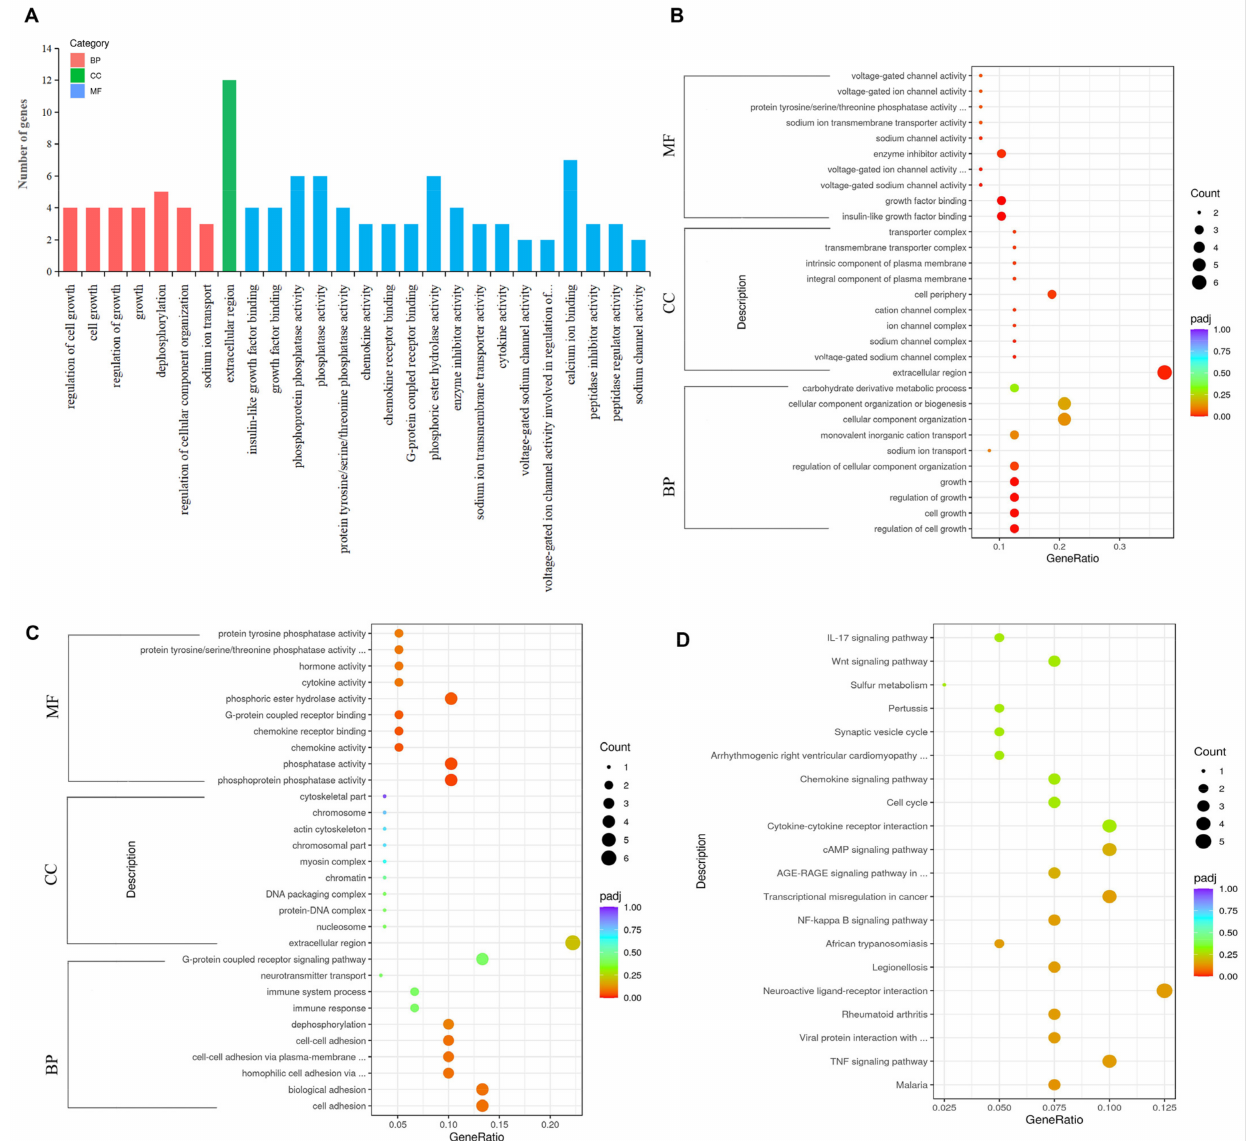
Figure 4. GO and KEGG enrichment analyses of DEGs of GCs between the 200 µ M NAC group and control group. ( A ) Statistics of GO enrichment. Histogram plots were generated with all differential significance terms. The abscissa is the GO term, and the ordinate is the number of genes enriched by the GO term. ( B ) Dot plot of upregulated gene-enriched GO terms. ( C ) Dot plot of downregulated gene-enriched GO terms. ( D ) Dot plot of top 20 KEGG pathways. The size of the dots represents the number of genes annotated onto GO terms and the KEGG pathways, and the colors from red to purple represent the significant size of